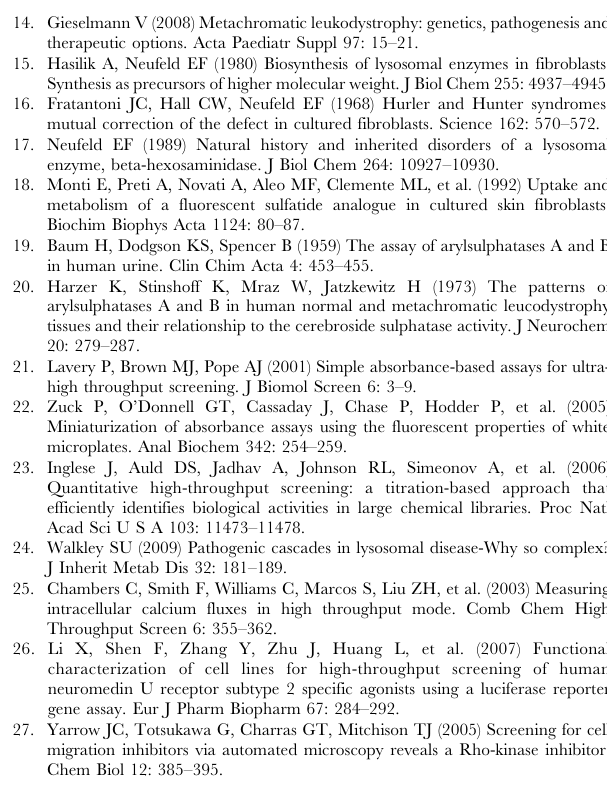
Table S1 Curve classification of concentration-response curves. Table S2 Cell viability assay for treatment of candidate compounds from